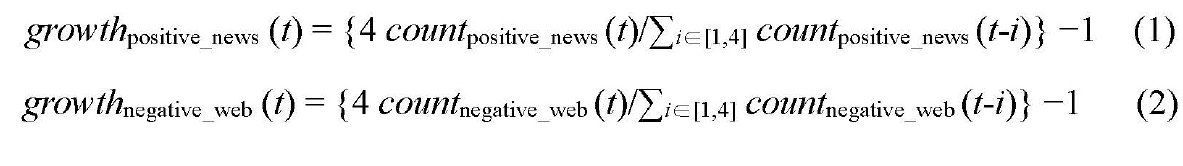
Figure 6. Equations for each month (t) where growth x(t) denotes the increase in the counted number, countx(t) of articles or Web pages corresponding to x at time t, in comparison with the average of the 4 preceding